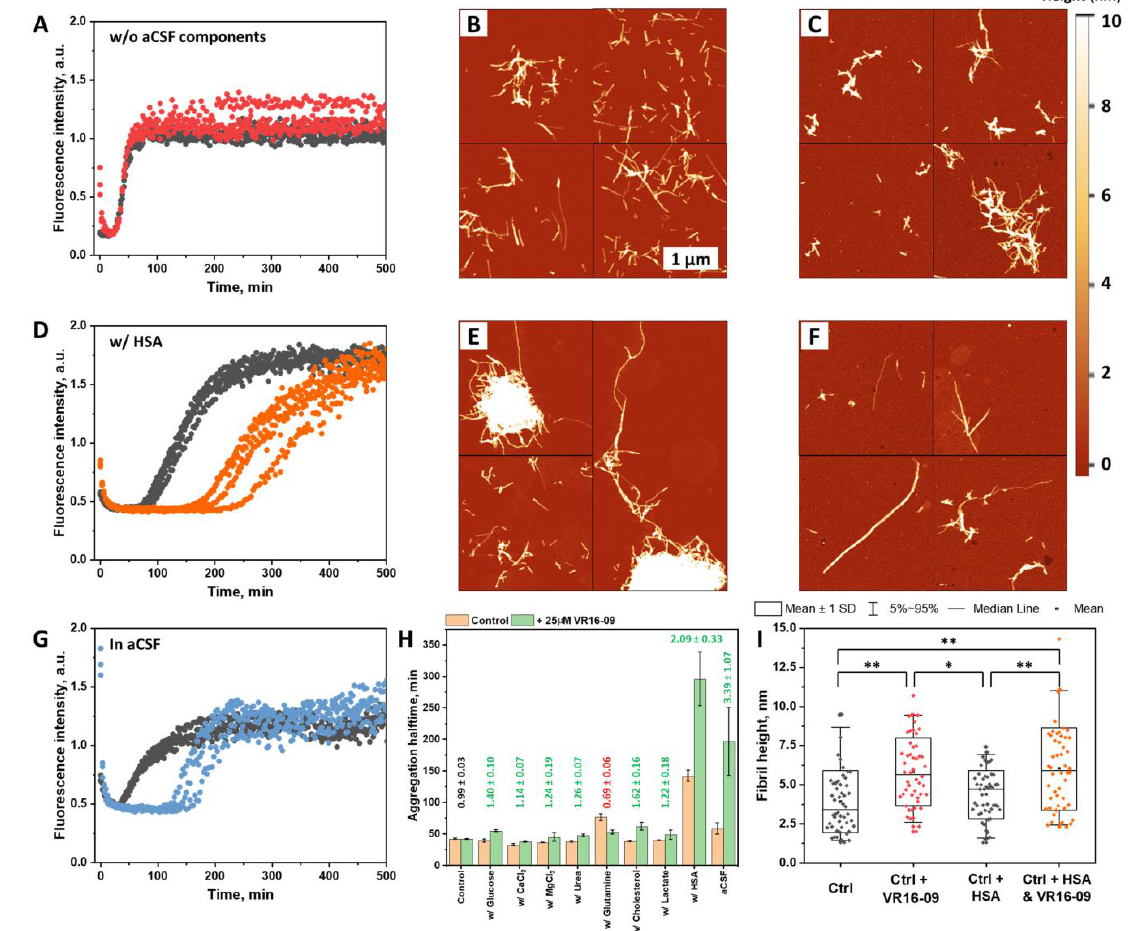
Figure 3. A β 42 (2 µ M) aggregation kinetics in the reaction mixture without aCSF components (control) ( A ), with HSA ( D ), and with all aCSF components ( G ) in the absence (black) or presence (colored) of 25 µ M of VR16-09. A β 42 aggregation halftime values ( H ) when aggregated with each aCSF component in the absence and presence of 25 µ M of VR16-09. Relative aggregation halftime values calculated between the sample with and without the inhibitor are listed above each column in green. Error bars are one standard deviation (n = 4). Atomic force microscopy (AFM) images of A β 42 aggregates formed in the reaction mixture without aCSF components ( B , C ) or with HSA ( E , F ) in the absence or presence of 25 µ M of VR16-09, respectively. Their height distribution box plot ( I ) indicates mean ± SD, and error bars are in the 5–95% range (n = 50). ANOVA (Bonferroni) significance values were compared, * p < 0.01, ** p <